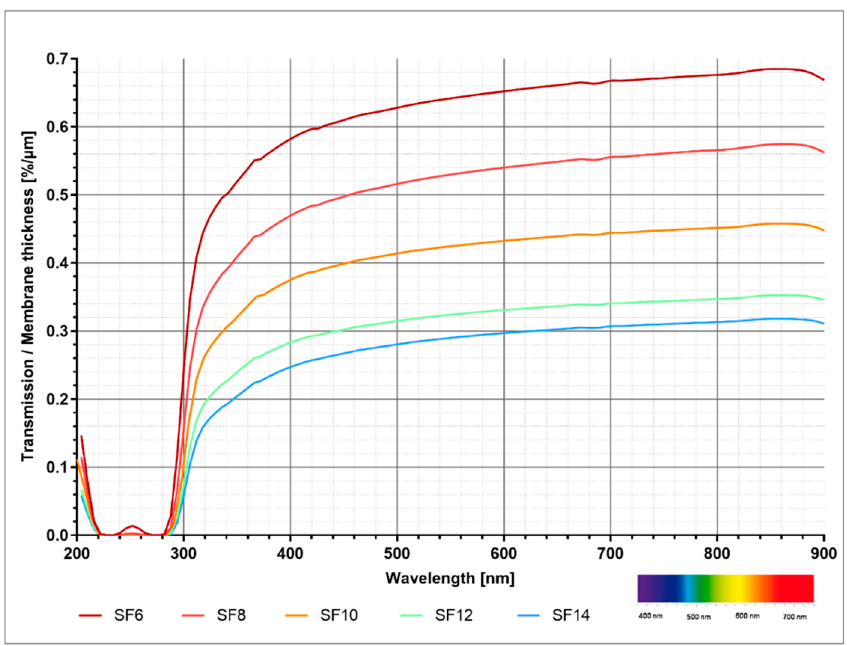
Figure 8. Adjusted degree of transmission in relation to the wavelength.